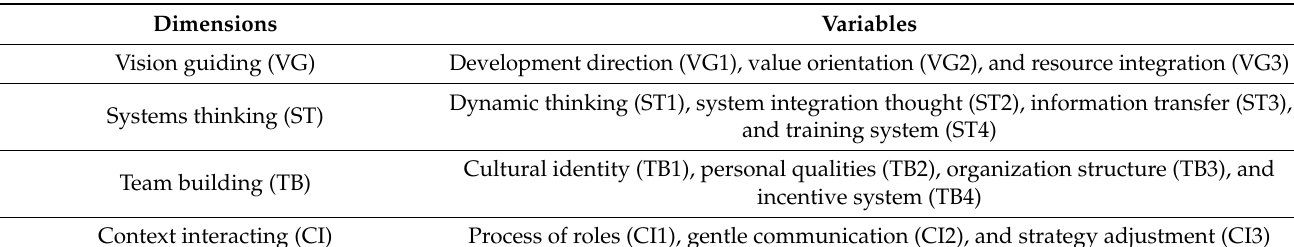
Table 5. Factors of organizational leadership for complex construction projects.